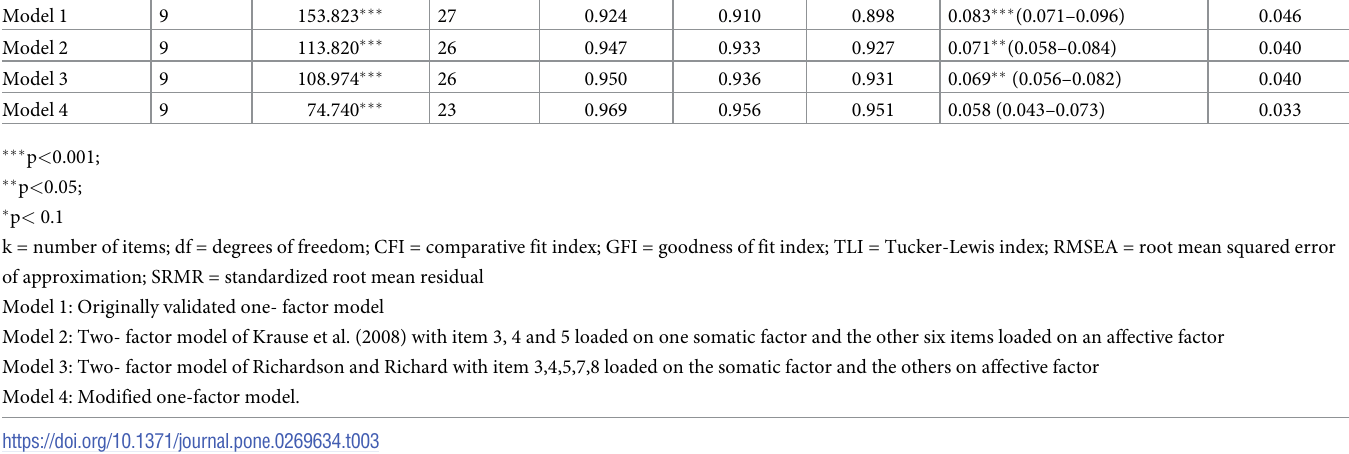
Table 3. Goodness of fit indices for the PHQ-9 item factor models (N = 677).